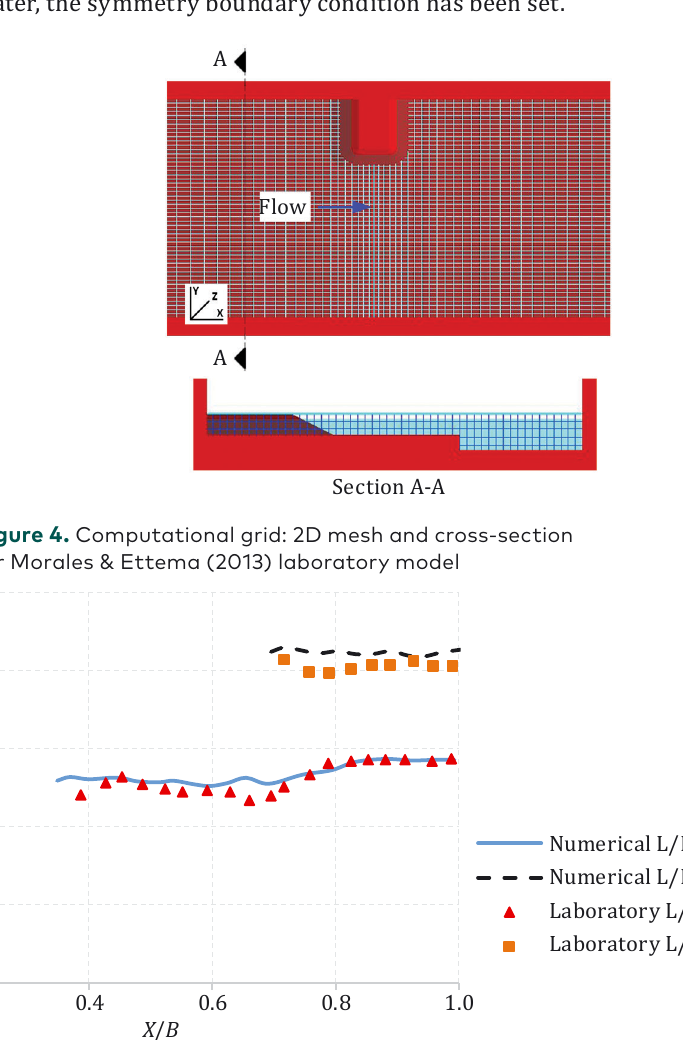
Figure 5. Comparison of model results and experimental measurements at cross-section passing through abutment